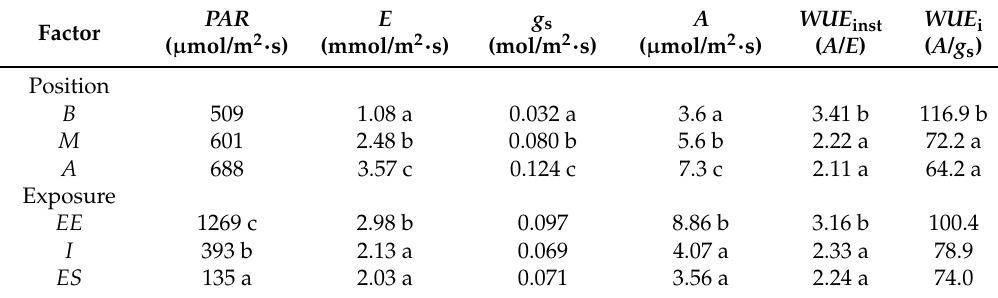
Table 6. Effect of leaf position ( B , M , A ) and exposure ( EE , I , ES ) on leaf gas exchange and water use efficiency. Data taken on 1 September. B = basal; M = median; A = apical. EE = exterior/exposed; I = interior; ES = exterior